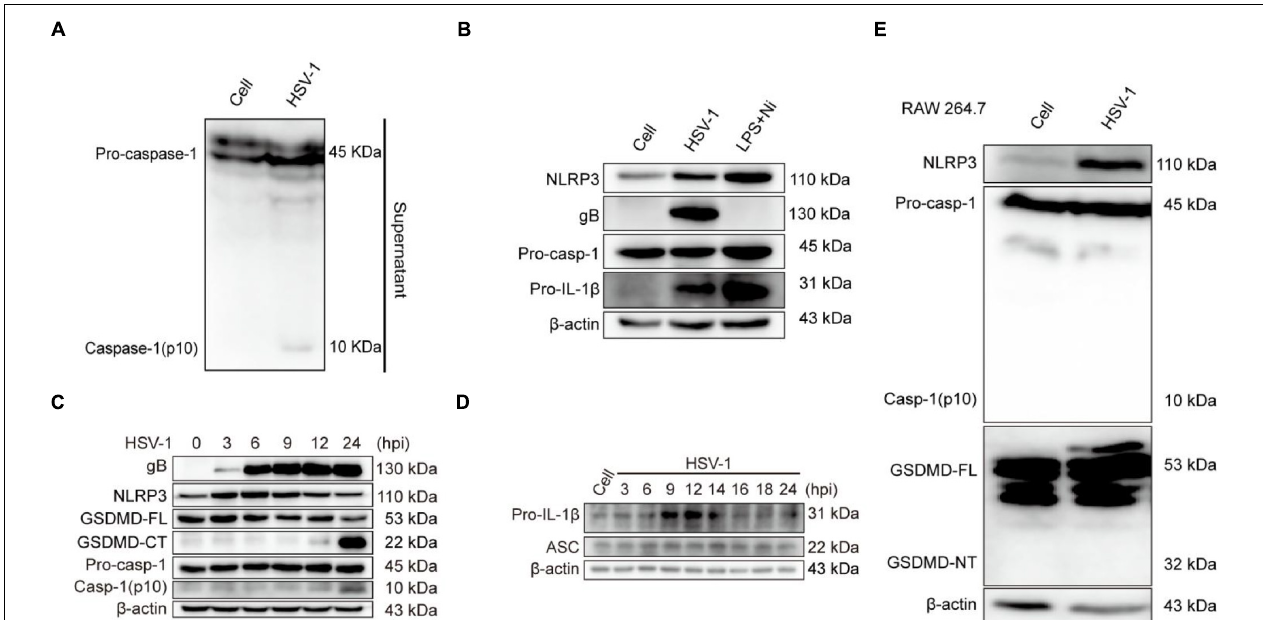
FIGURE 3 | NLRP3 Inflammasome is involved in HSV-1-induced pyroptosis. (A) Western blot analysis of indicated proteins in the supernatants (Sup), BV2 infected with HSV-1 (MOI = 5, 24 hpi). (B) BV2 cells treated with 1 µ g/mL lipopolysaccharides (LPS) for 4 h followed by 2 µ g/mL nigericin for 2 h or HSV-1 infection (MOI = 5, 24 hpi), the level of NLRP3, pro-caspase-1, gB, and IL-1 β was detected by Western blot. LPS + Nigericin in uninfected cells served as a positive control. (C,D) Immunoblot analysis of extracts of BV2 cells infected by HSV-1 (MOI = 5) for the indicated time points by the indicated antibodies. (E) The expression levels